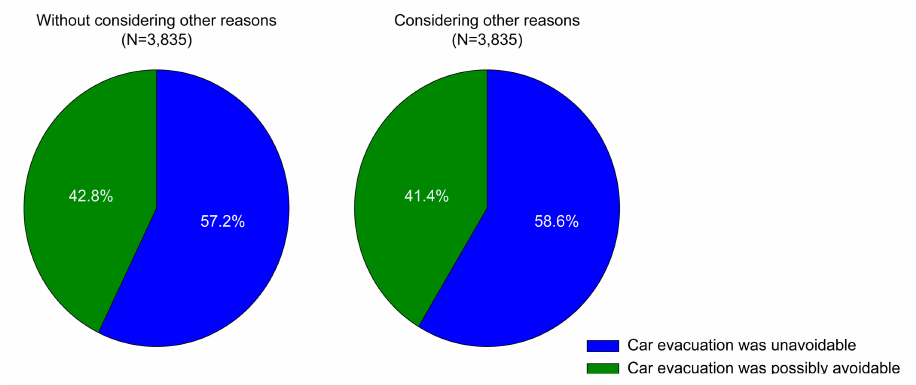
Figure 9. Estimated car evacuation avoidability during the 2011